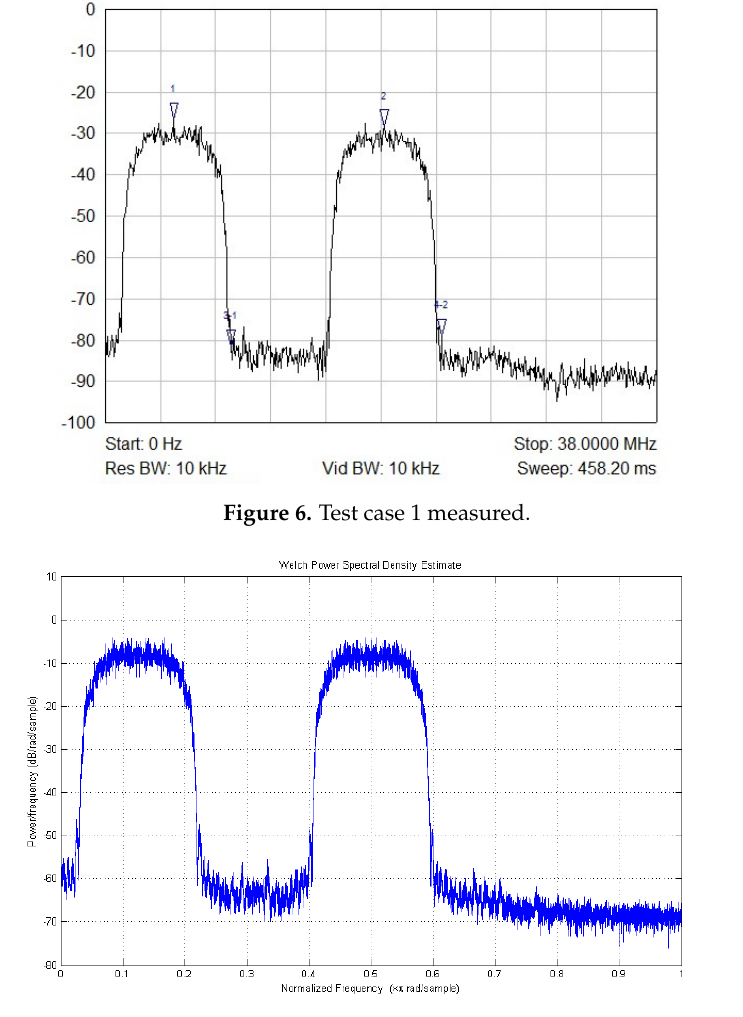
Figure 7. Test case 1